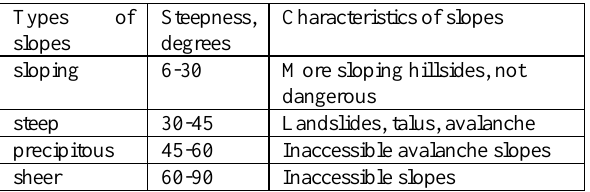
Figure 3. Avalanche zone in Trans-Ili